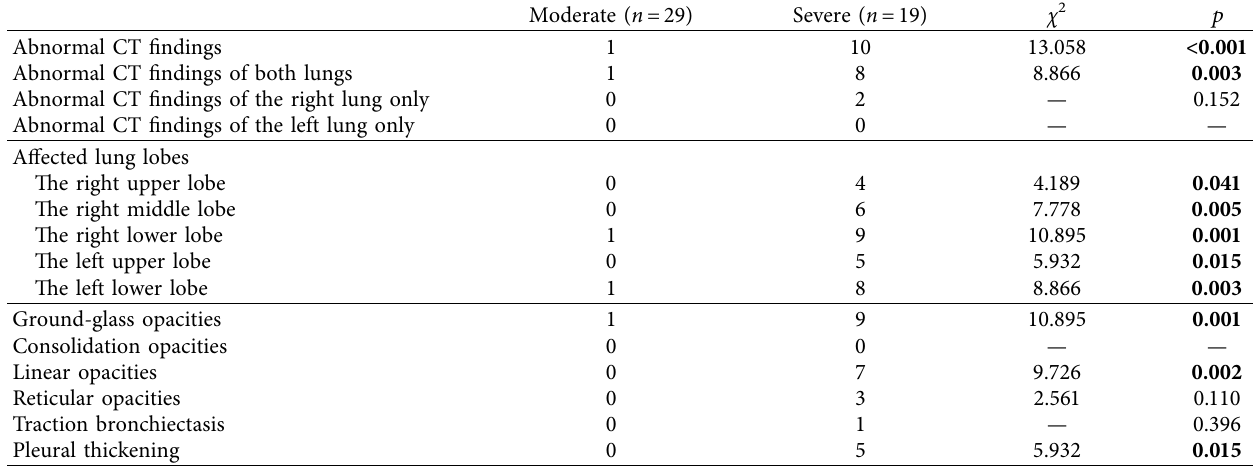
Table 5: Comparison of chest CT between moderate and severe patients 6 months after discharge.